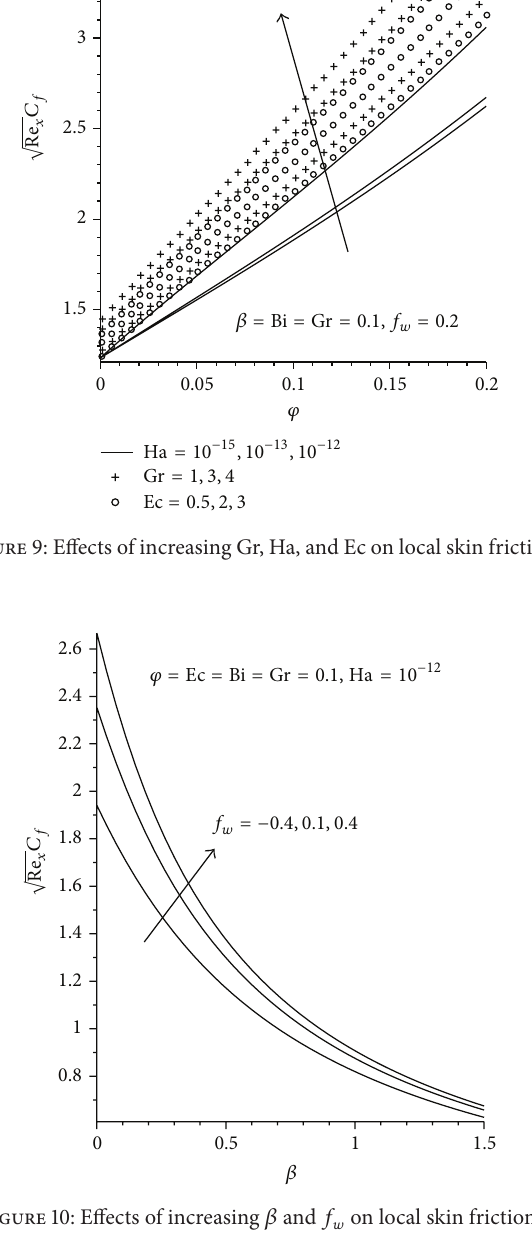
Figure 8: Local skin friction profiles for different nanofluids. (rate of heat transfer). The presence of nanoparticle in the convectional fluid leads to an increase in the skin friction, as seen in Figure 8, where increasing the nanoparticle volume fraction increases the skin friction for the three nanoparticles (Cu, Al 2 O 3 , and TiO 2 ) used, with Cu-water exhibiting the highest increment. This is as expected, since Cu-water moves closer to the plate surface leading to an elevation in the